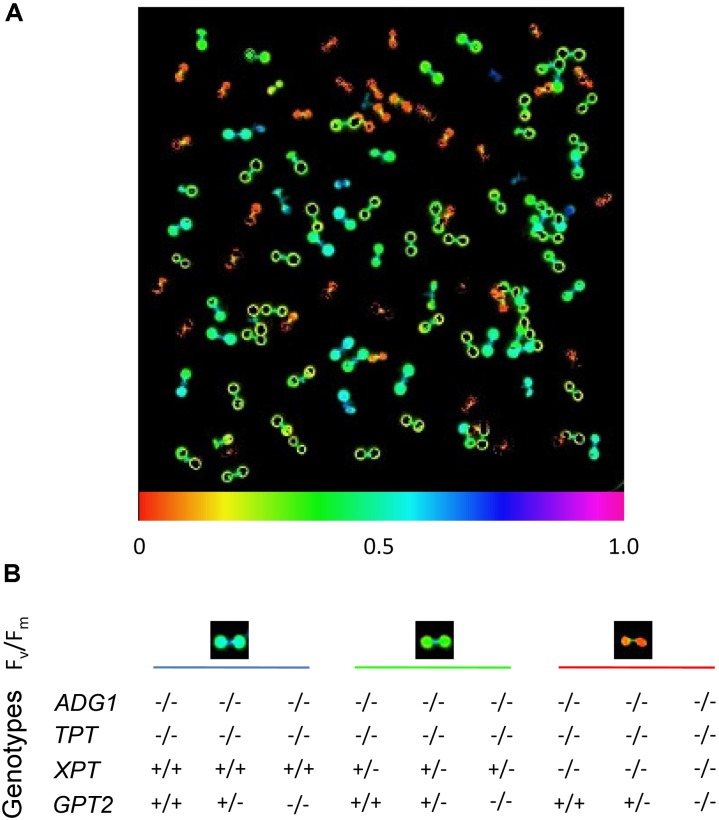
Chl a fluorescence phenotype of seedlings from a segregating mutant population defective in ADG1, TPT, XPT and GPT2. The plants were germinated and grown on 1/2MS agar plates supplemented with 50 mM sucrose under long-day conditions and a PFD of 150 μmol⋅m-2⋅s-1 for 8 days. (A) Seedlings were dark-adapted for 30 min and the Fv/Fm-ratio determined by PAM fluorometry. (B) Correlation between the Fv/Fm-ratios with the genotype of the mutants (determined on day 28). The Fv/Fm-ratio dropped from around 0.5 in adg1-1/tpt-2 double or adg1-1/tpt-2/gpt2-1 triple mutants, to around 0.35 when the xpt-1 mutation was in the heterozygous state and reached 0.06 in homozygous adg1-1/tpt-2/xpt-1 triple mutants, irrespectively whether GPT2 was knocked out homo- or heterozygously.